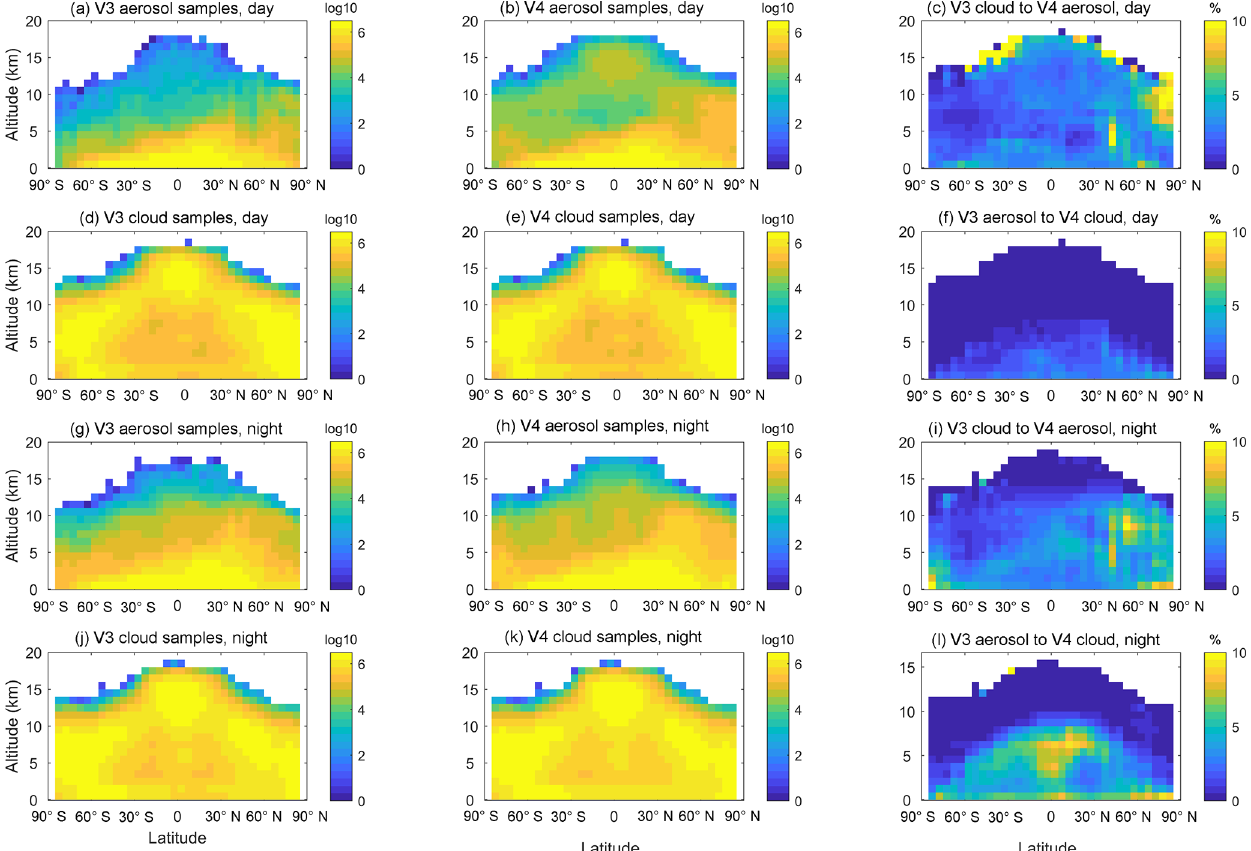
Figure 17. Altitude–latitude distributions of aerosol and cloud scene samples of V3 (a, d, g, j) and V4 (b, e, h, k) as well as the fractional changes (c, f, i, l) of the total V3 cloud and aerosol scenes derived from 1 year (2008) of the CALIOP day (a–f) and night (g–l) profile